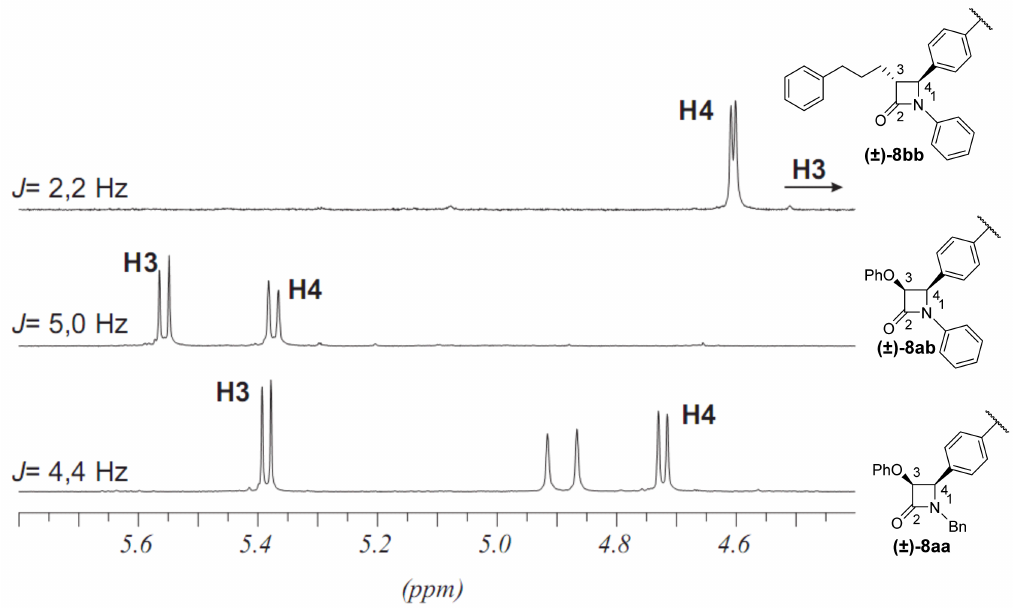
Figure 2. Comparative 1 H-NMR spectra of 3,4- cis - and trans -substituted β -lactams. Table 1. The secondary “trifluoroacetic acid (TFA)” library of β -lactams.